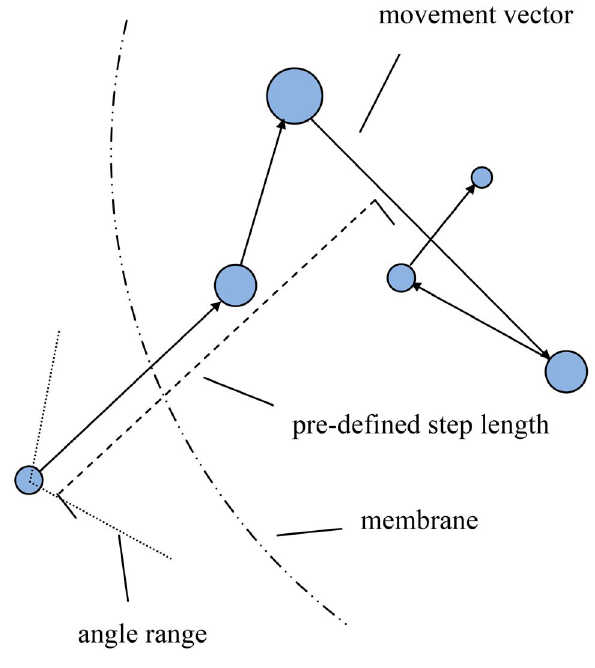
Figure 6. The 3-D movement of an O 2 molecule during five successive iterations. Within a pre-defined limit (step length) the agent moves a random distance per iteration. For O 2 this is also used to imitate the diffusion along the concentration gradient according to Fick’s first law, in which the flux goes from regions of high concentration to regions of low concentration with a magnitude that is proportional to the concentration gradient (spatial derivative). The adjustment of step length of O 2 (Table 4) affects the spatial moving speed, which is simply represented as the greater the step length, the faster the movement. The angle range was defined for O 2 molecules that are outside the cell to enable them move towards cell. The O 2 molecules inside the cell and all other molecules move in any direction within their defined spatial regions.